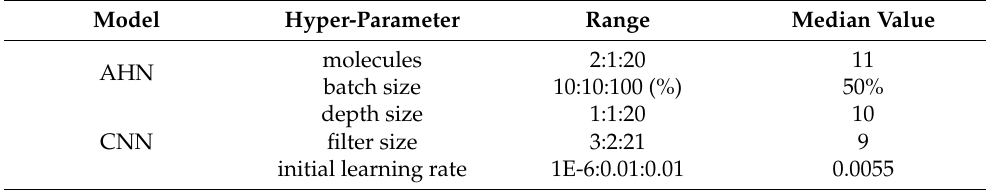
Table 3. Setup of the hyper-parameters for the models. Ranges are written as (lower bound:step:upper bound).